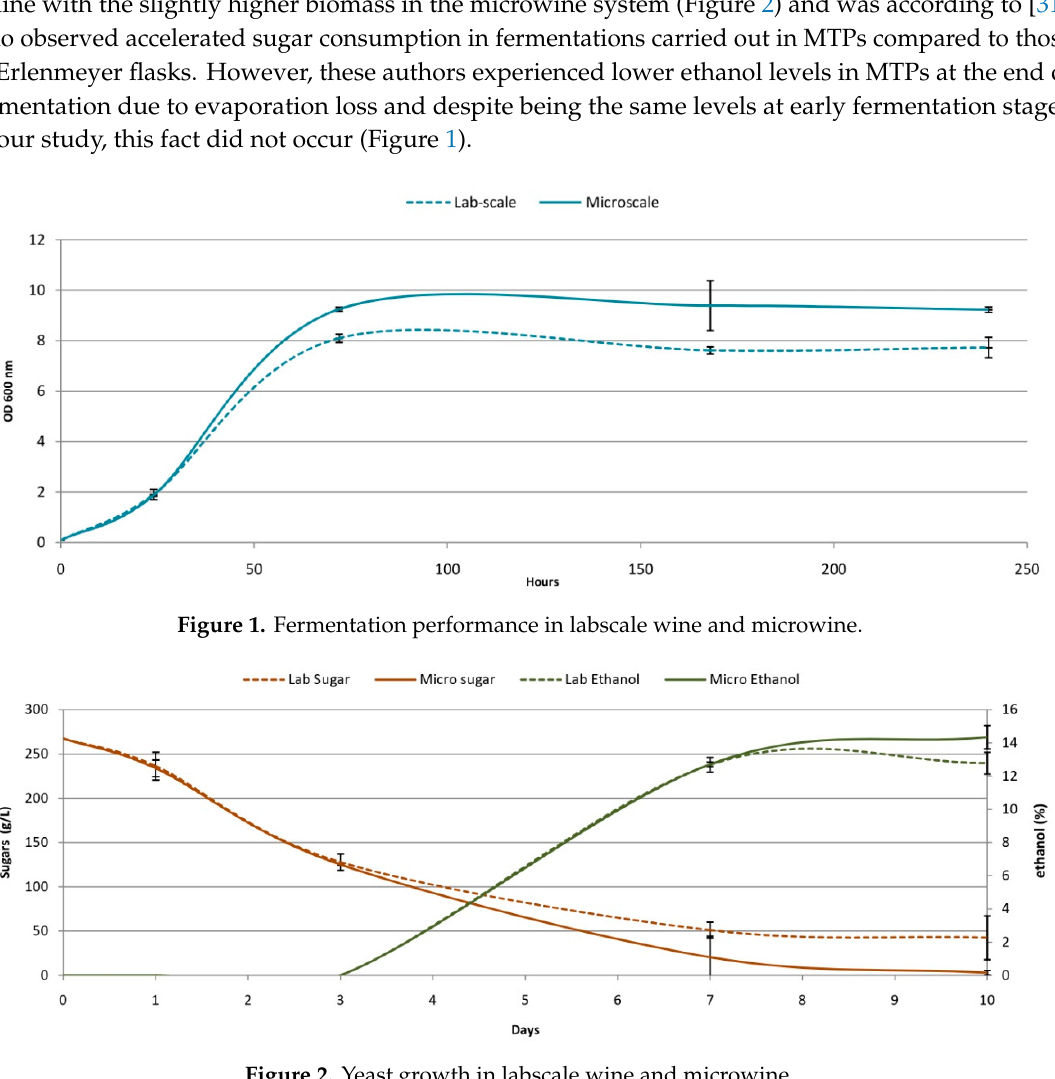
Figure 2. Yeast growth in labscale wine and microwine.